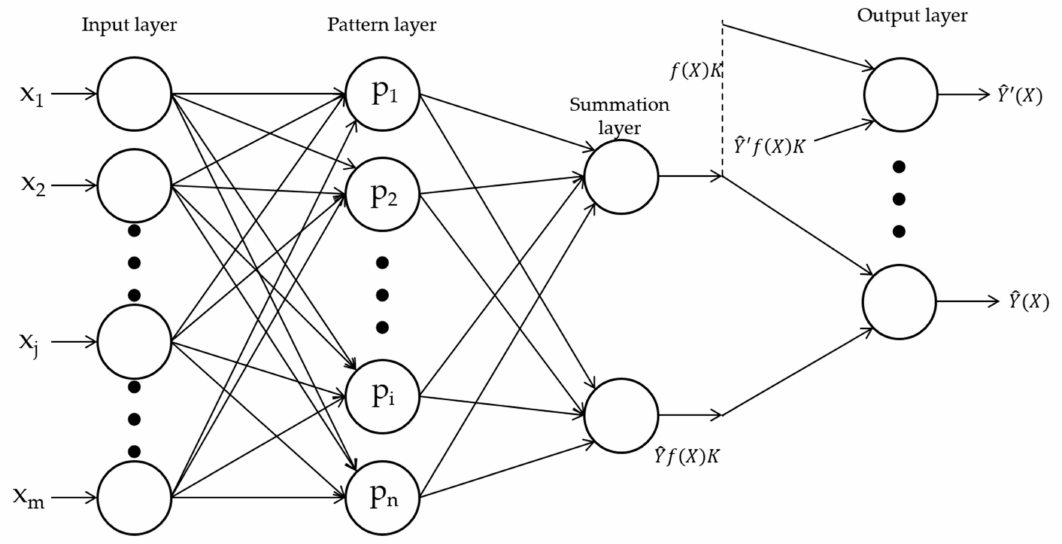
Figure 4. Schematic diagram of generalized regression neural network (GRNN) model